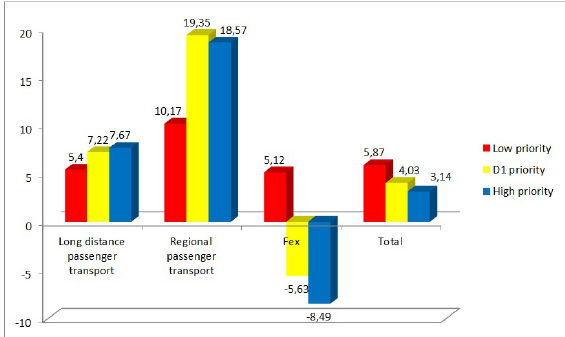
Figure 2. Average delay increment for different vari- ants of Fex train